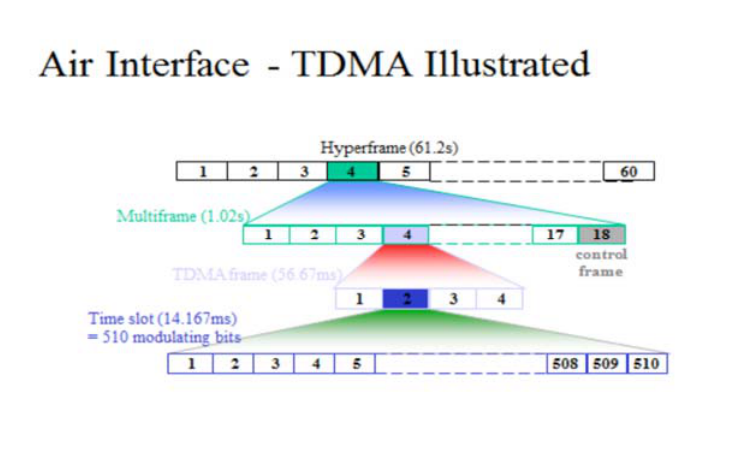
Figure 5 – Overview of the hierarchy of time structures in the TETRA system (123seminarsonly,